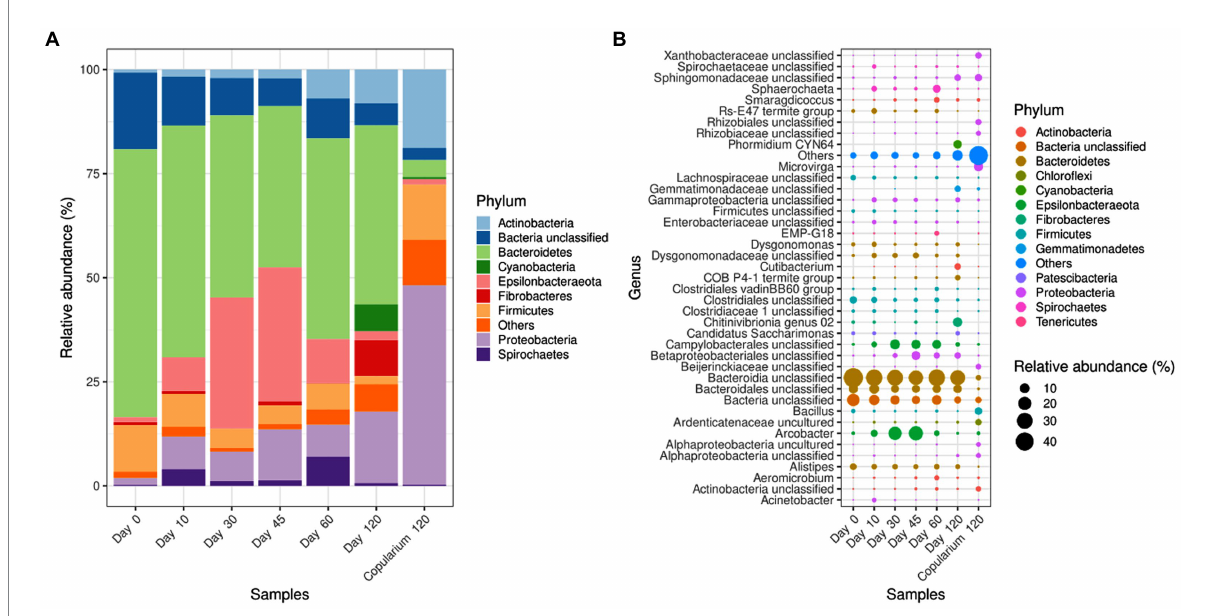
FIGURE 6 Phylum-level (A) and genus-level (B) distribution of bacterial taxa in the gut of M. subhyalinus reproductives over the colony foundation period, in comparison with the copularium at day 120. For the genus-level, only the 40 most abundant taxa of the data set are displayed. The dot sizes are proportional to the relative abundance of the corresponding taxa in each library and the absence of dot indicates the non-detection of the corresponding taxon in a given library. “Others” refer to the sum of relative abundances of less abundant